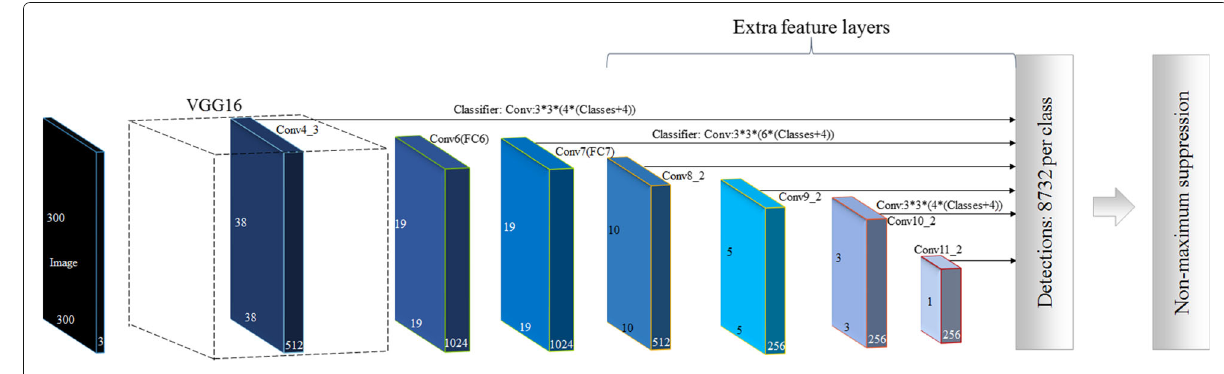
Fig. 2 Architecture of SSD 300